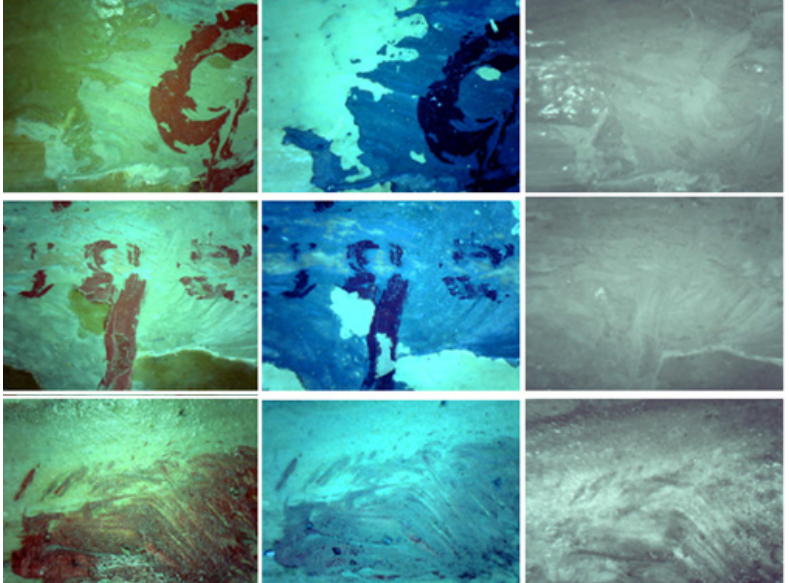
Figure 8. Analysis in the three reflected lights: white-green (550 nm), UV (365 nm), and IR (850 nm) of some areas with signature characters in Figure 7 and of other area where false writing is suspected.